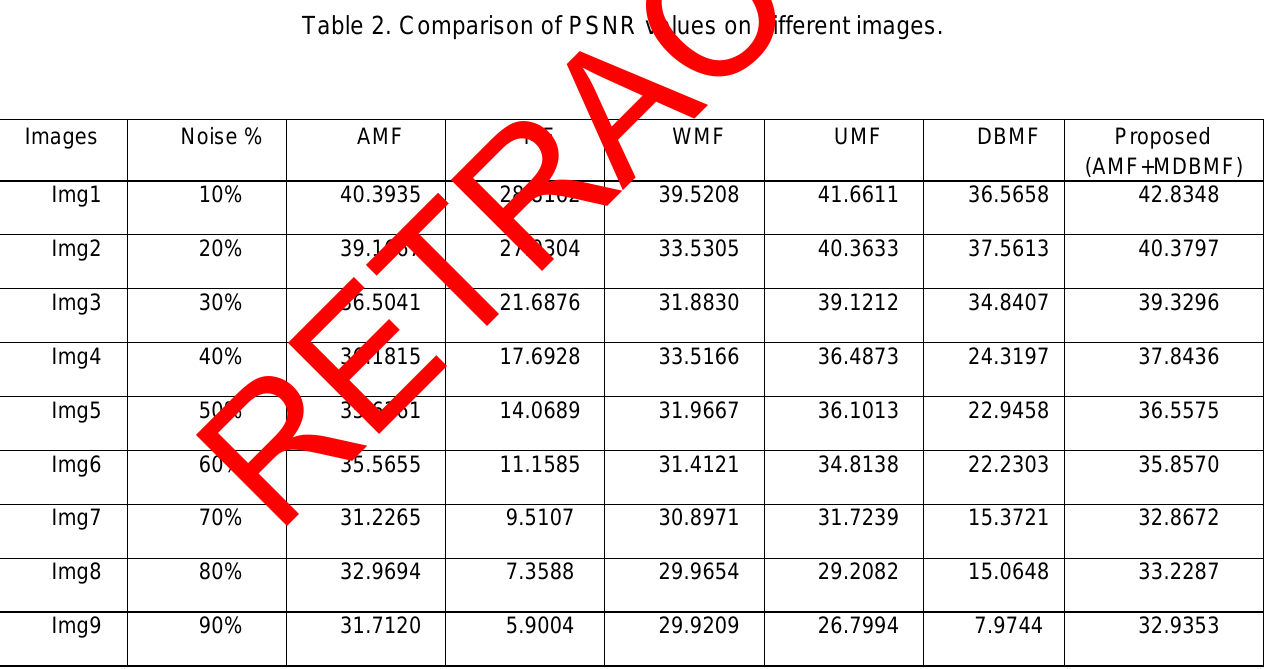
Table 2. Comparison of PSNR values on different